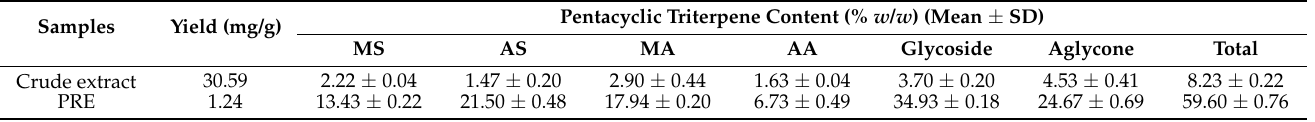
Figure 1. The dried powder ( A ), the crude extract ( B ), and PRE ( C ) from C. asiatica . Table 1. Pentacyclic triterpene content of PRE and crude extracts from C. asiatica.